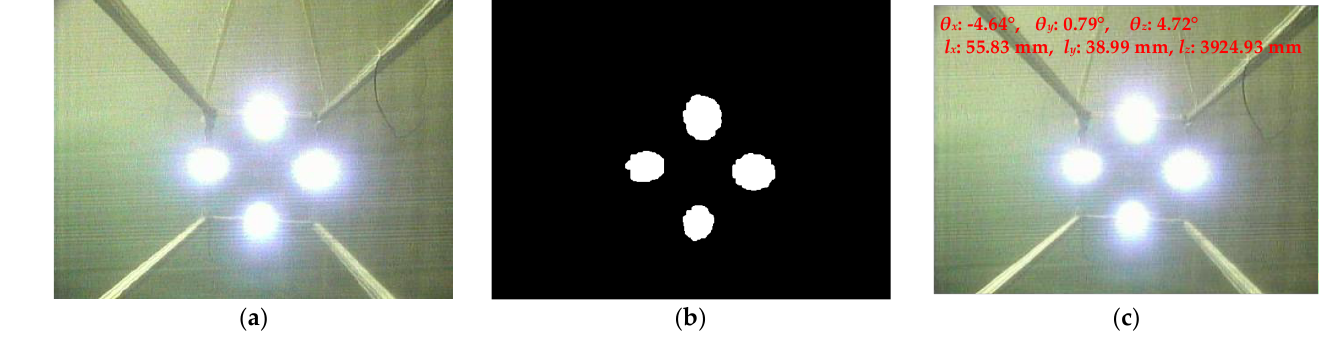
Figure 17. Example of PPARD estimation: ( a ) original image; ( b ) extracted guidance features; ( c ) PPARD estimation result.